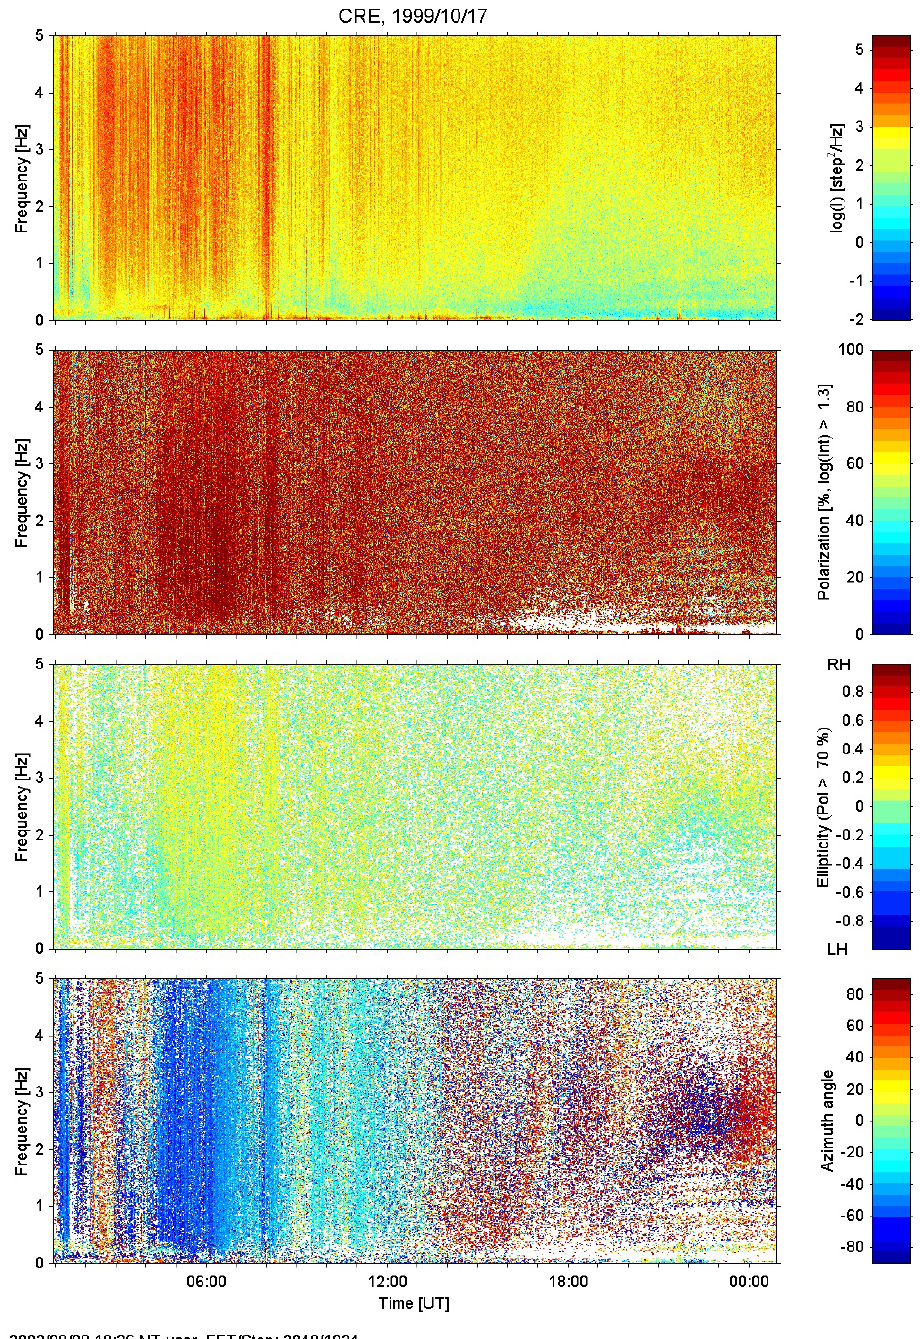
Fig. 4. The same as Fig. 3 but for the previous day; cf. also Fig.